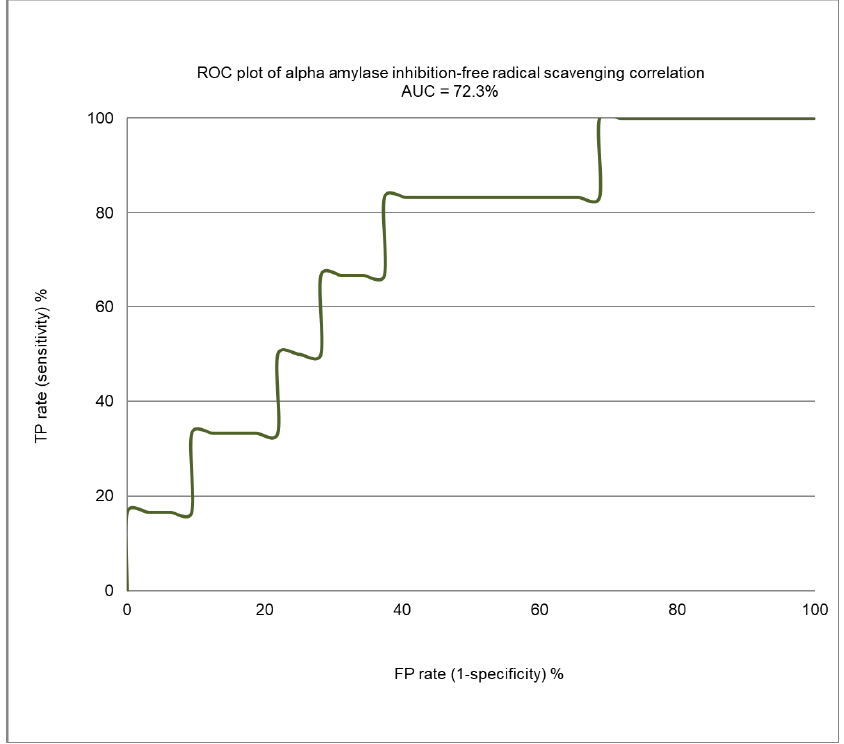
Figure 5. A receiver operating characteristic (ROC) curve showing the performance of the FRSA-α-amylase inhibition correlation model.